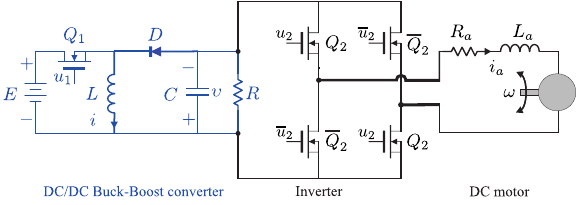
Figure 1. DC/DC Buck-Boost converter–inverter–DC motor